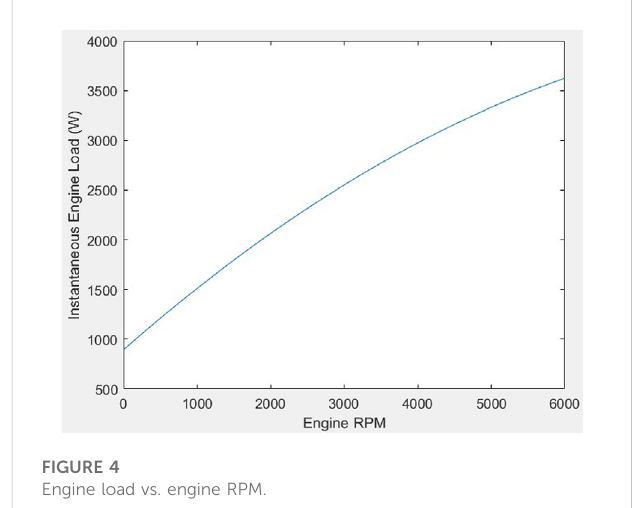
FIGURE 4 Engine load vs. engine